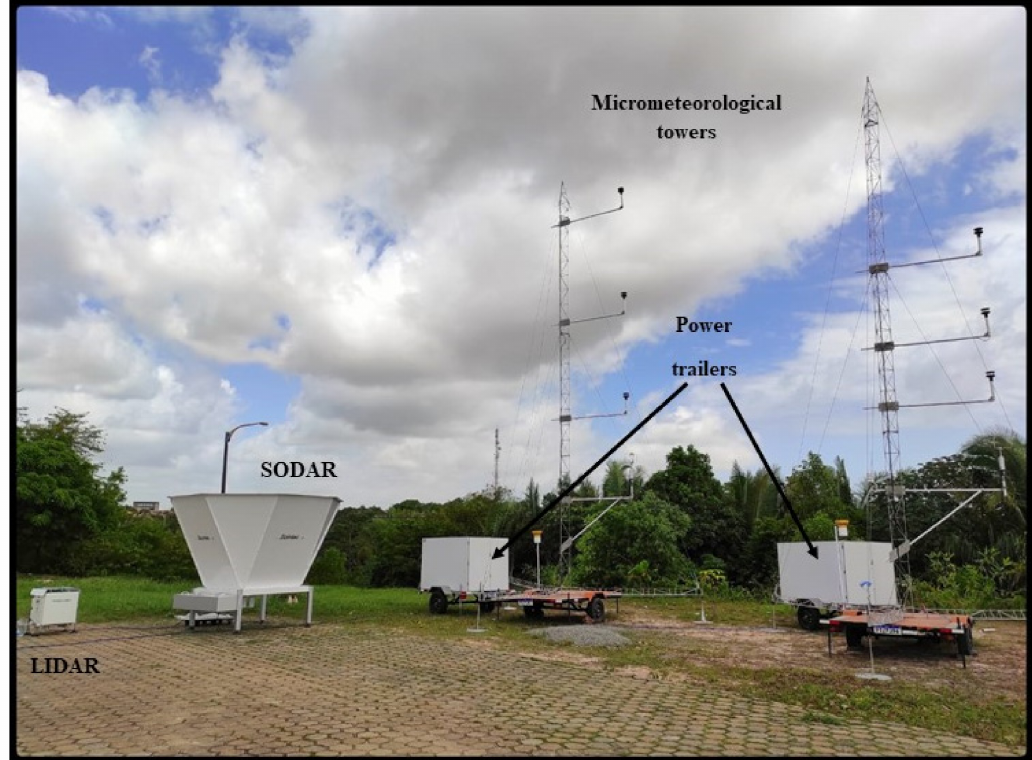
Figure 4. EOSOLAR measuring stations. From left to right: LIDAR, SODAR, and micrometeorological towers. Trailers refer to the power stations solutions (solar panels with batteries). Photo illustrates instruments mounted on the UFMA campus for the testing and intercomparison campaign (Table